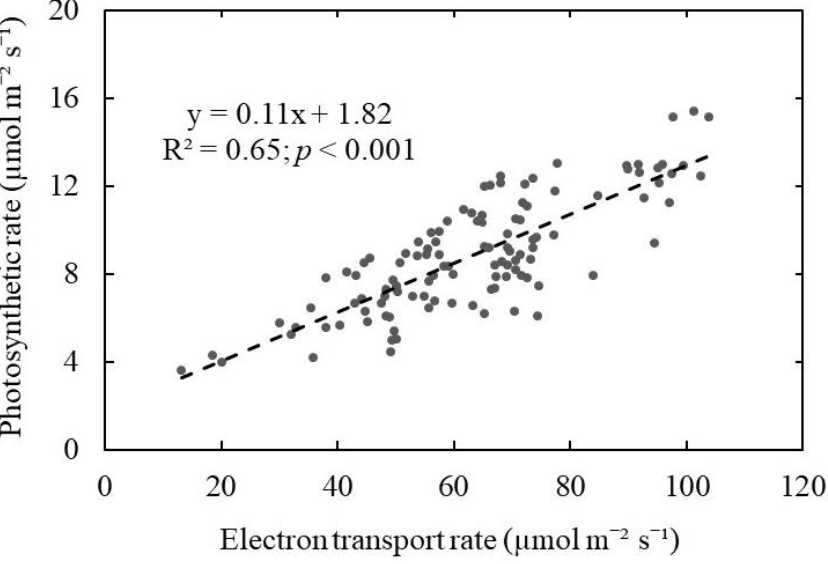
Figure 6. Relationship between leaf photosynthetic rates (CO 2 assimilation) and electron transport rates for wild blueberry plants. The dashed line represents a linear relationship fitted to the data by linear regression analysis ( p < 0.001).